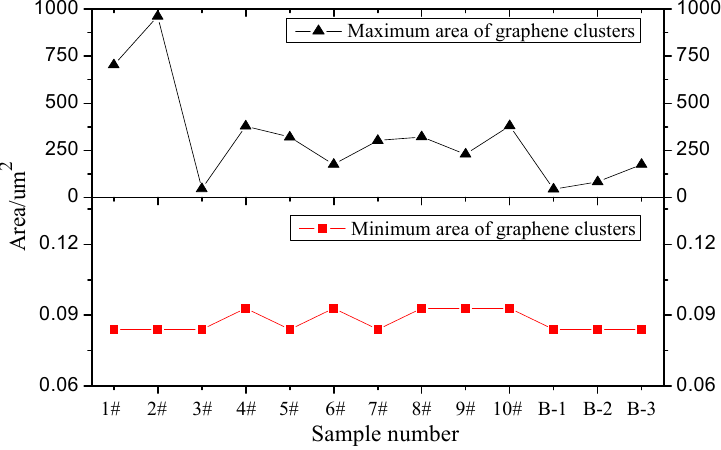
Figure 7. Variation trend of graphene cluster max and min areas.